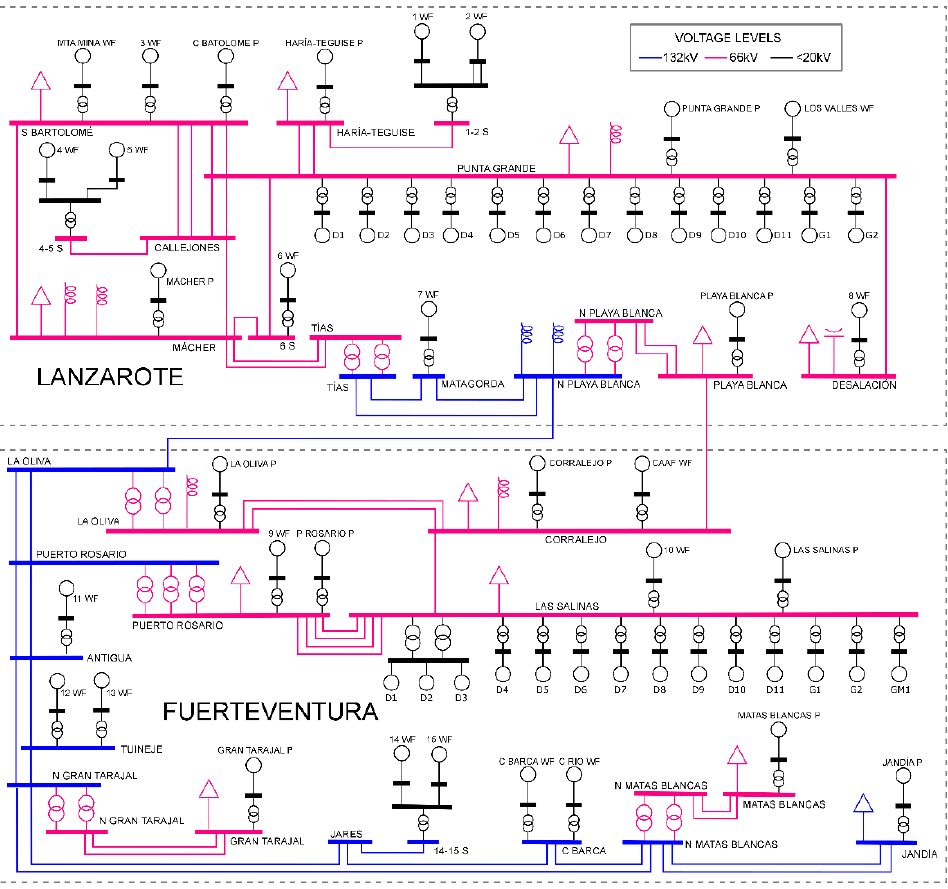
Figure 1. Lanzarote ‐ Fuerteventura power system expected by the year 2020. Figure 1. Lanzarote-Fuerteventura power system expected by the year